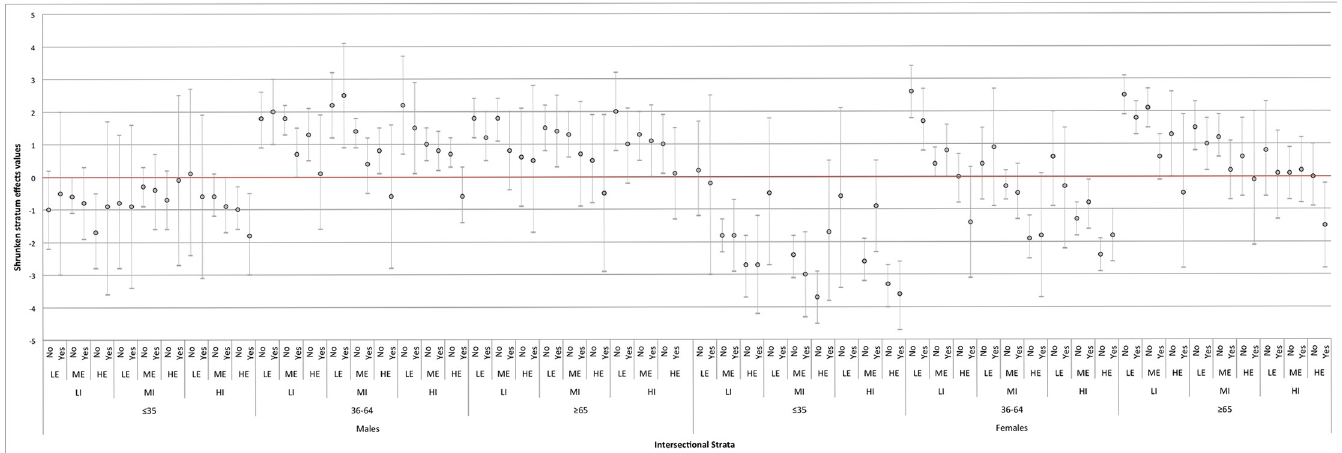
Fig 2. Differences between the estimated average BMI in each intersectional stratum and the overall population average BMI (i.e., shrunken stratum effects values from the simple intersectional model 1). The intersectional strata are ordered according to the demographic and socioeconomic dimensions used to define the strata. The red horizontal line at value 0 corresponds with the population average BMI. The exact values and the specific definition of the intersectional strata are indicated in the S1 Table. LI: Low Income; MI: Medium Income; HI: High Income. LE: Low Education; ME: Medium Education; HE: High Education.